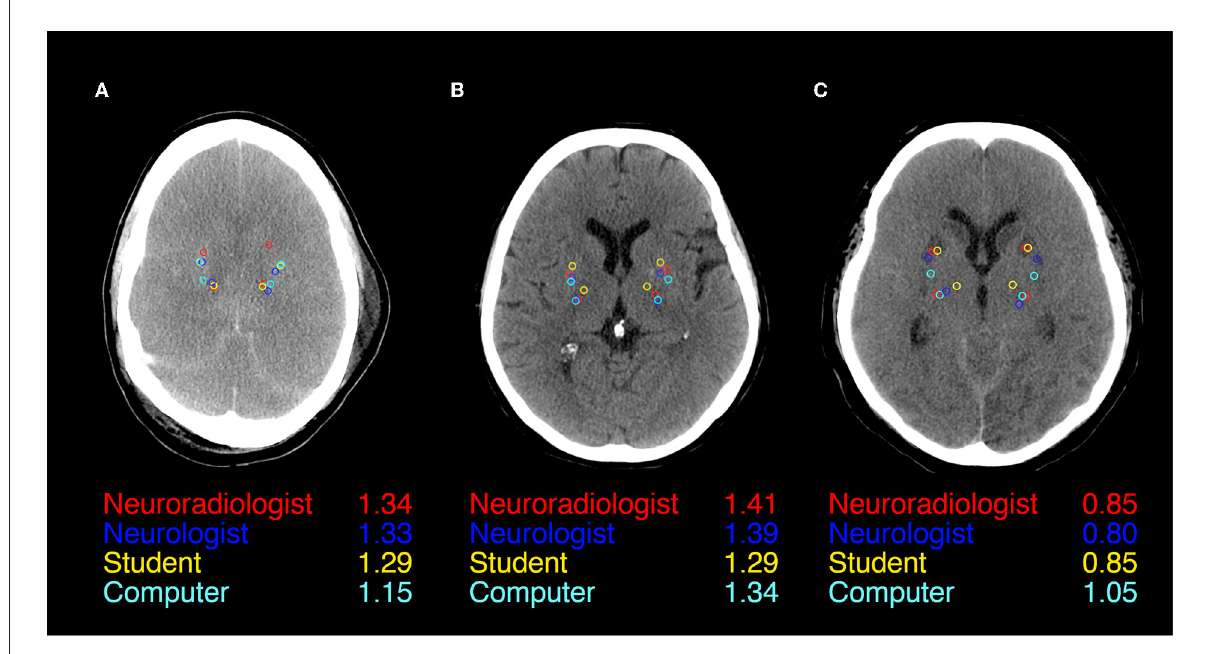
FIGURE1 ROI Placement during GWR assessment in Putamen and Posterior Limb of the internal Capsule (PLIC) in CTs of three patients after cardiac arrest (A–C) . All four raters (Neuroradiologist in red, Neurologist in blue, Student in yellow, and Computer in cyan) and GWRs displayed.